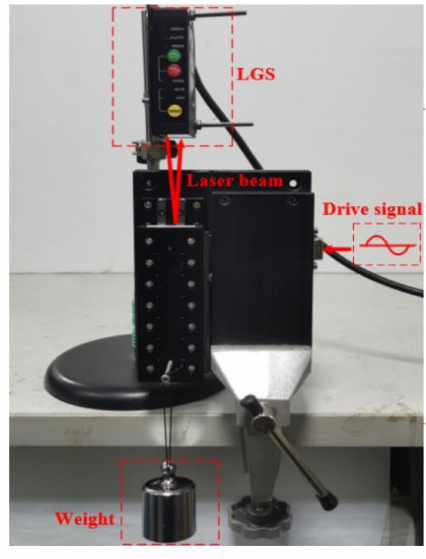
Figure 6. Experimental platform.